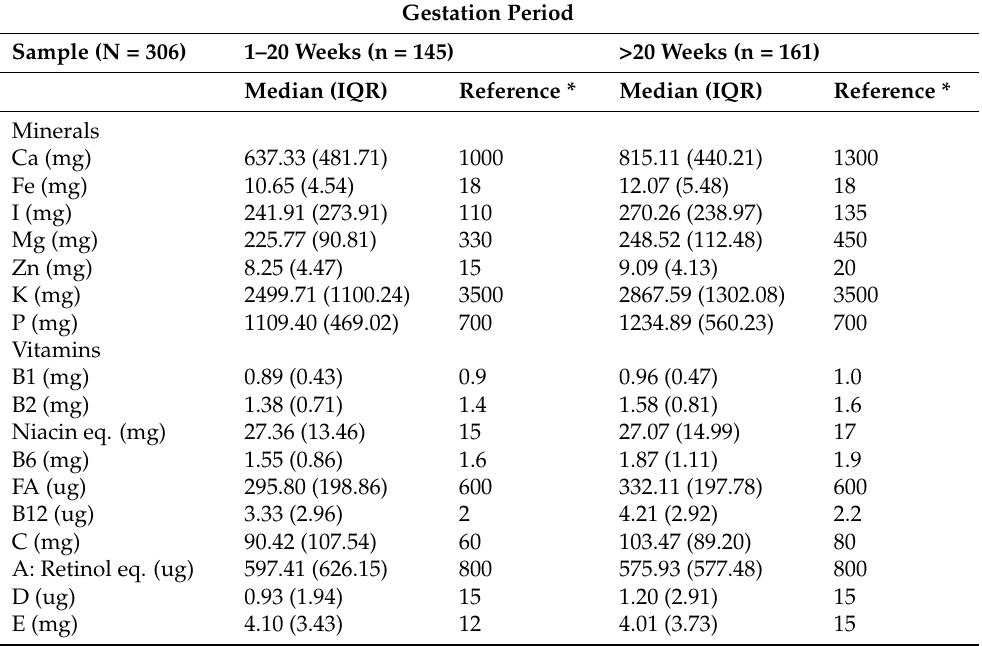
Table 6. Mean intake of minerals and vitamins according to gestation period and recommendations (median and interquartile range).